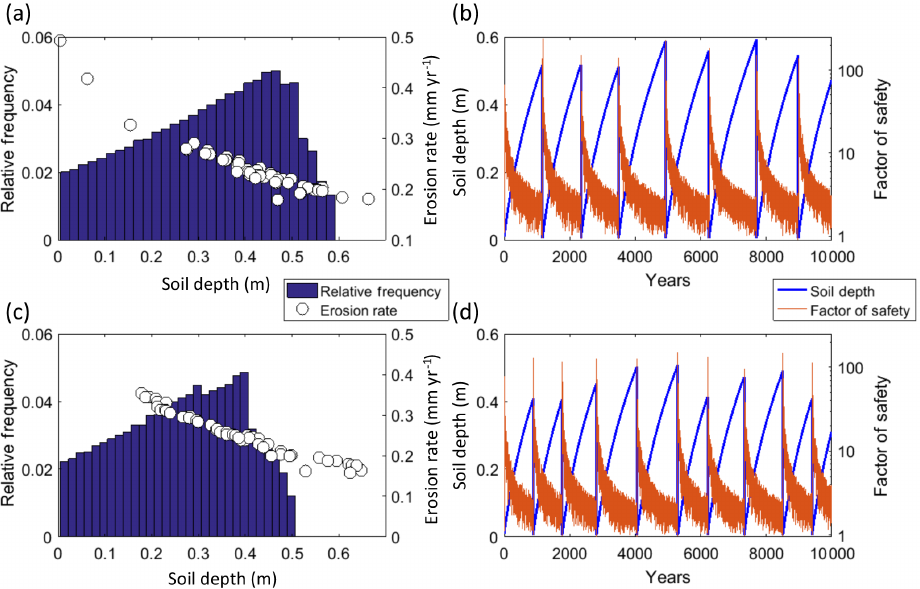
Figure 6. Illustration of the soil evolution model run using (a, b) steep slope (40 ◦ ) class and forest vegetation and (c, d) moderately steep slope (29 ◦ ) class and shrub vegetation. (a, c) Modeled mean annual erosion rates plotted with respect to the mode of modeled soil depth, along with soil depth temporal relative frequency for a representative convergent location. (b, d) Temporal evolution of soil depth and FS (logarithmic scale) for a representative convergent (Curv =− 0.01) location.